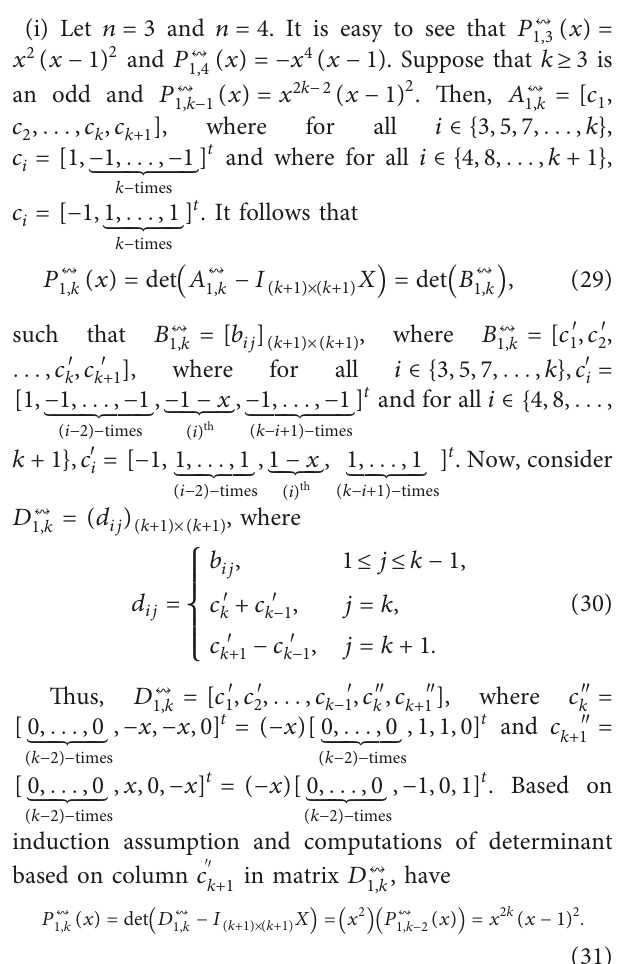
, S , φ ( 2 ) , . .. , φ ( m + n − 2 ) 􏽮 􏽯 , φ ( 1 ) 􏽮 􏽯 ) i j i,j j,i j,i